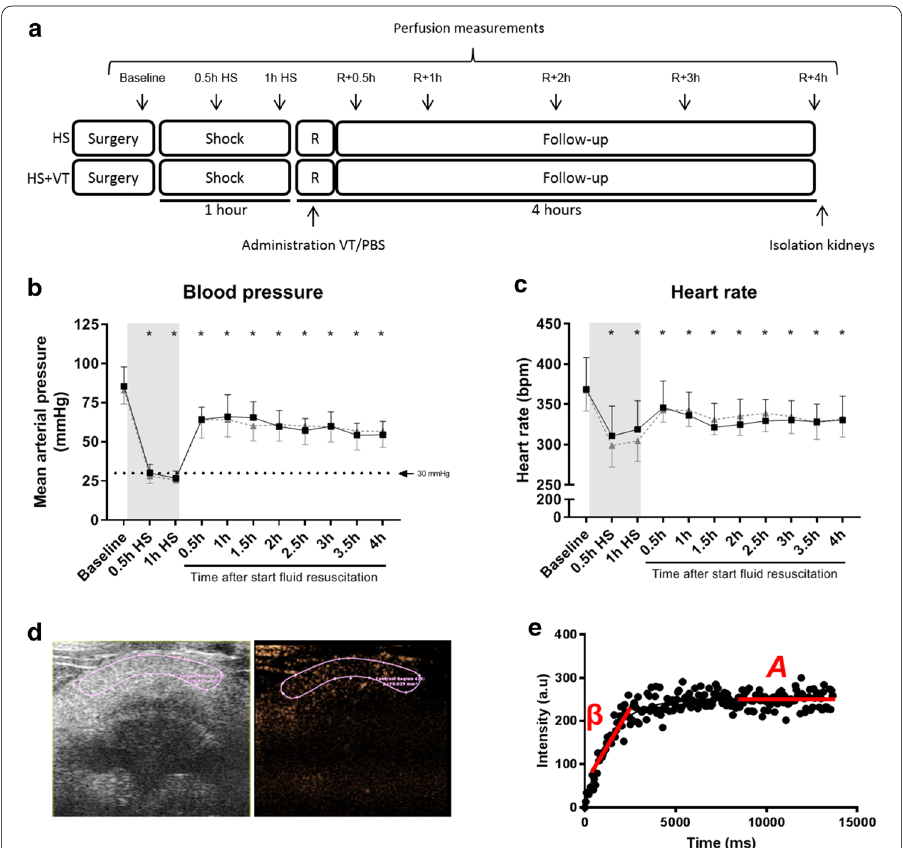
Fig. 1 Experimental protocol. Schematic overview of experimental protocol ( a ). Hemorrhagic shock was induced by pressure-controlled blood withdrawal, and mean arterial pressure (MAP) was maintained for 1 h at 30 mmHg (shock). After 1 h of shock, animals were resuscitated with fluids (R), which was paralleled by administration of vasculotide (VT) as treatment or PBS as control, and monitored for 4 consecutive hours ( b , c ). Renal and cremaster perfusion measurements were performed directly after the surgical preparation (baseline), 30 min after shock induction (0.5 h HS), 1 h after shock induction (1 h HS), and 30 min (R 0.5 h), + 1 h (R 1 h), 2 h (R 2 h), 3 h (R 3 h) and 4 h (R 4 h) after start of fluid resuscitation. Plasma was collected + + + + at baseline and before killing (4 h after starting fluid resuscitation). Rats were killed and kidneys were isolated for additional molecular analyses and determination of edema formation. d , e An example of renal perfusion analysis. Regions of interest were drawn in the cortex of the kidney ( d ). The estimate of perfusion was calculated as the product of microvascular blood volume A and microvascular filling velocity β ( e ). Two-way ANOVA with Bonferroni post hoc analyses, *P < 0.05 HS group compared to baseline; # P < 0.05 HS VT vs. HS + group. Data represent mean SD, n ± =